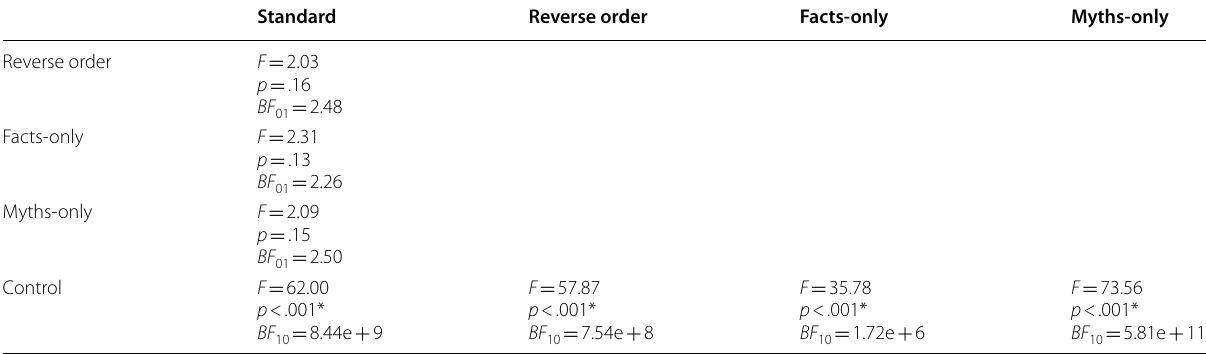
All df1 1, df2 98; * indicates significance after Holm–Bonferroni correction = =